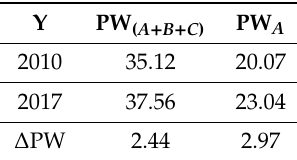
Table 3. Changes of indicator PW ( A + B + C ) (%) and PW A (%) (author’s elaboration on MIUR data 2010 and